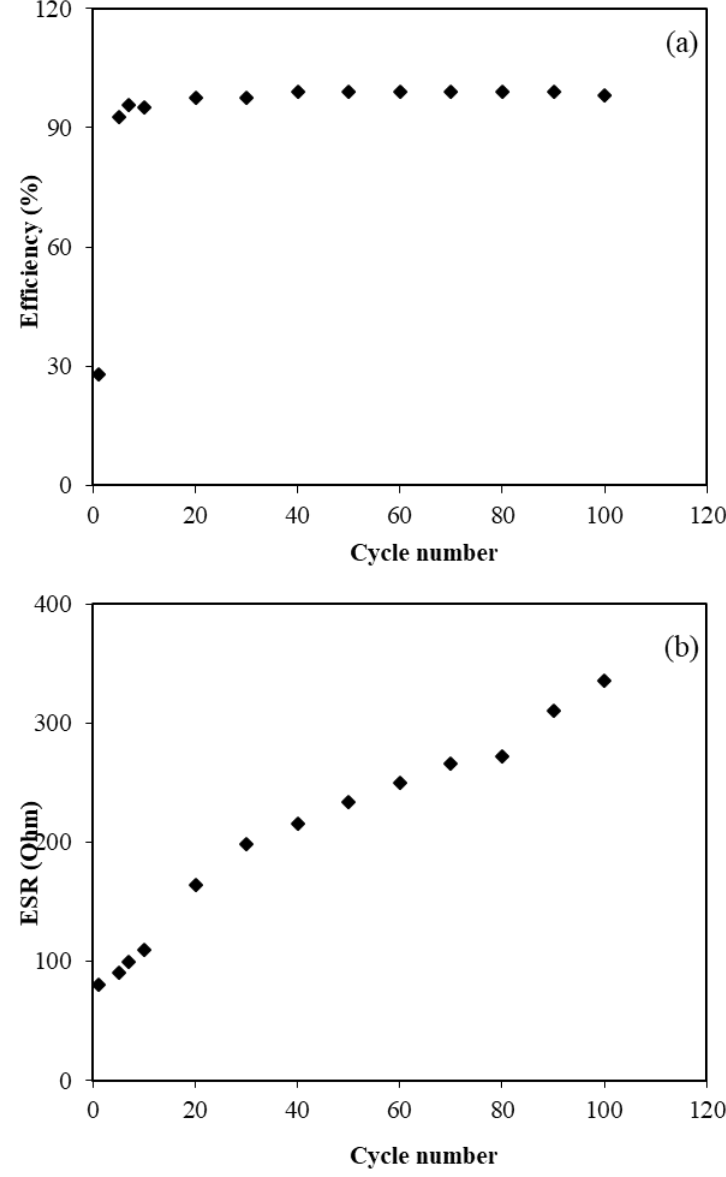
Figure 8. The plot of ( a ) efficiency, and ( b ) ESR of the fabricated EDLC for 100 cycles.